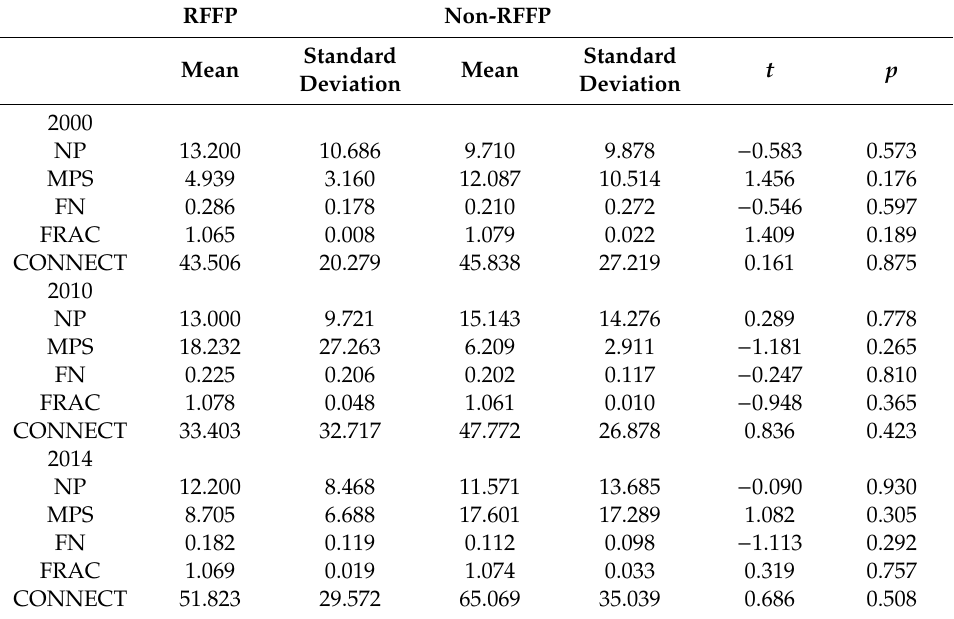
Refer to Table 3 for the abbreviations for landscape